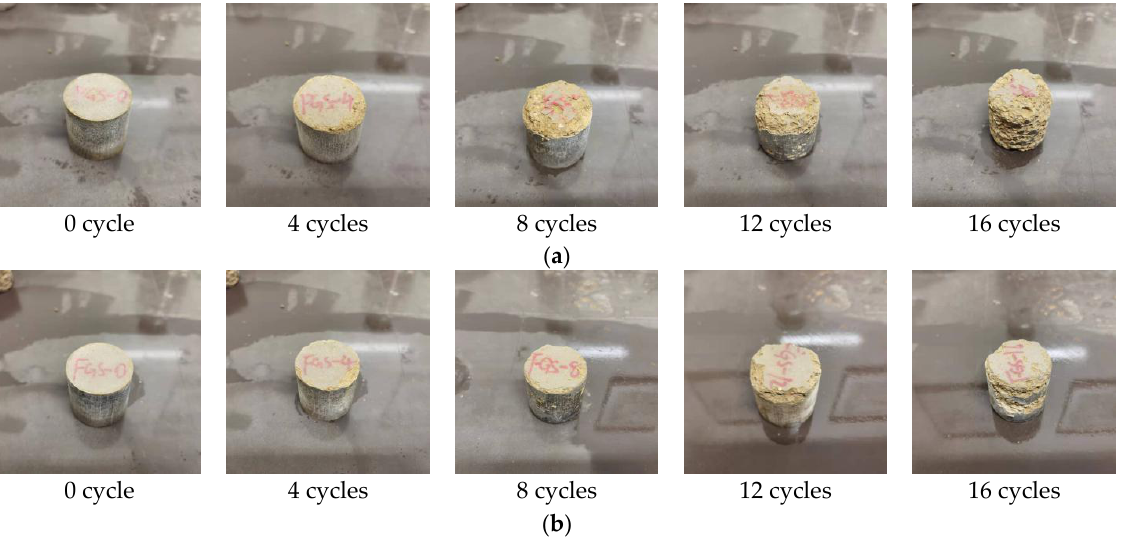
Figure 6. ( a ) Damage of ordinary-cemented soil subjected to wetting – drying cycles (cured for 28 d). ( b ) Damage of composite-cemented soil subjected to wetting – drying cycles (cured for 28 d).